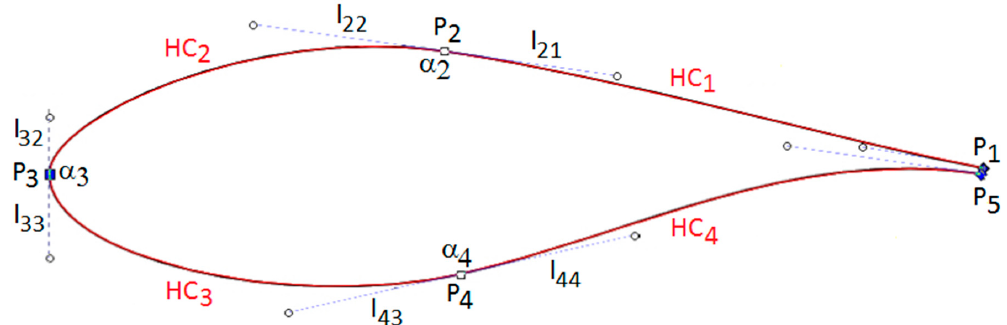
Figure 4. Parametric representation of airfoil shape by Hermite curves.